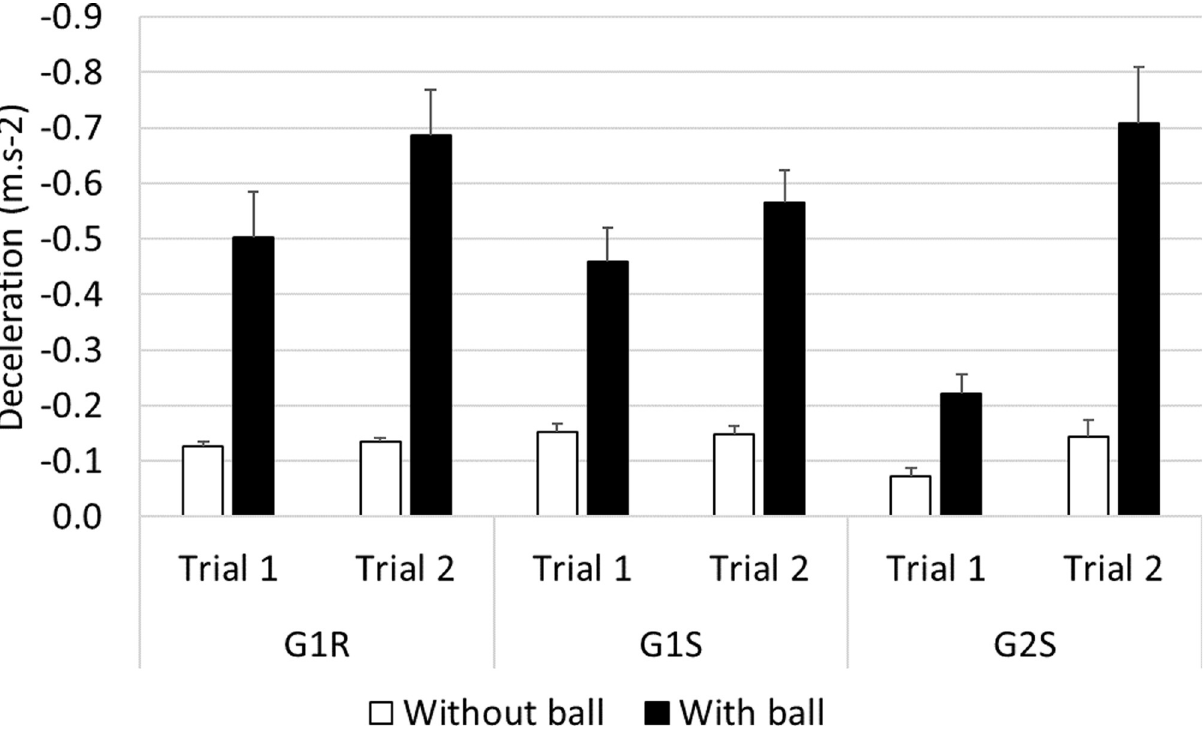
Fig 9. Deceleration of vehicles, based on the mean speed